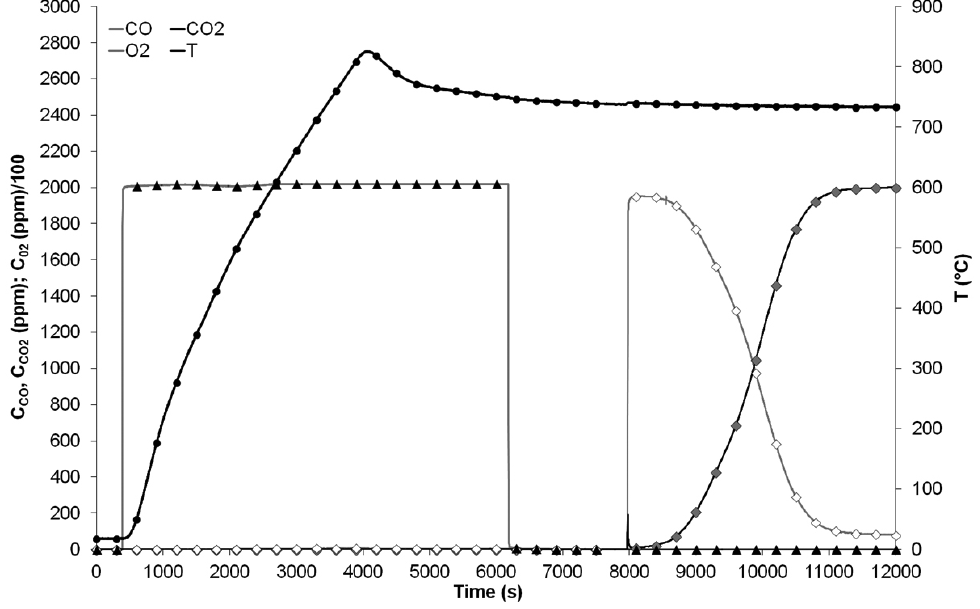
O (0.2% CO, 750 °C, 50 NL.h –1 ) according 2 4